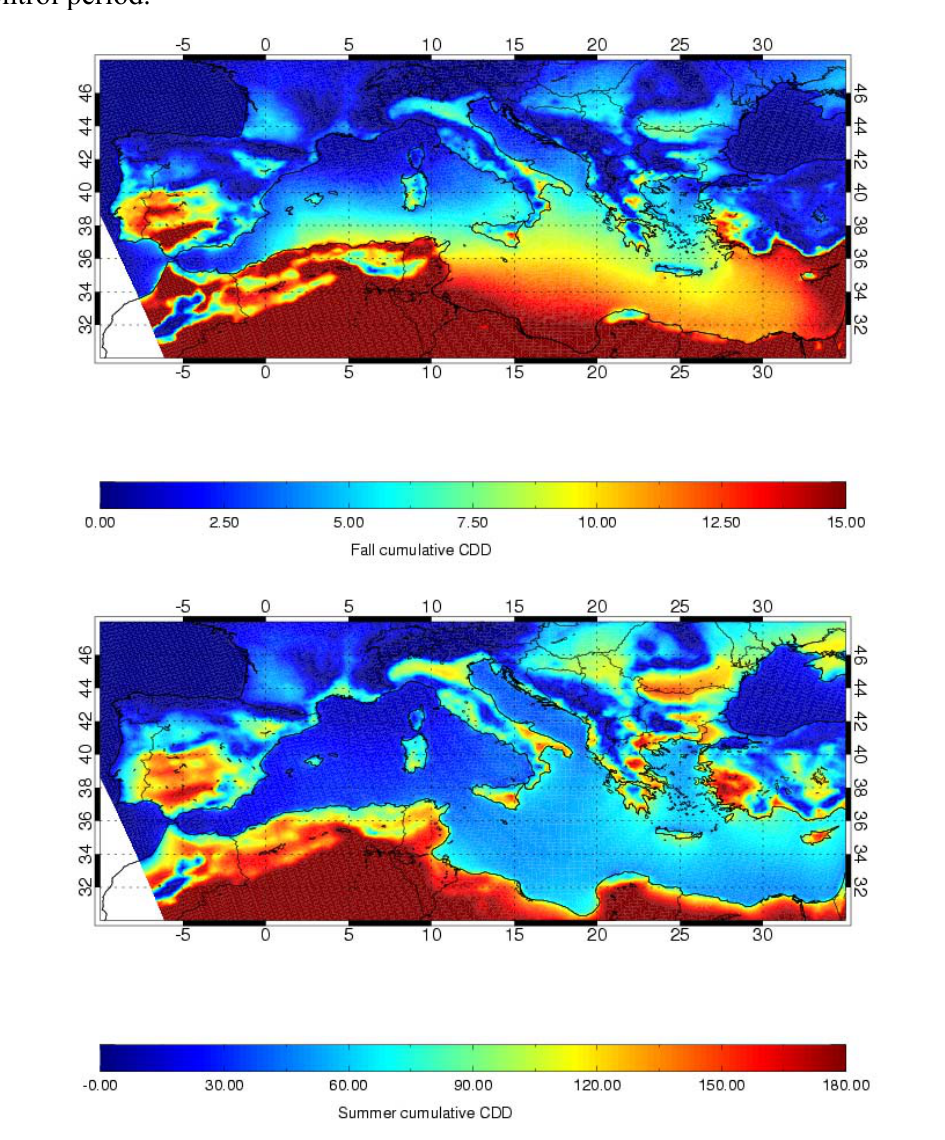
Figure 1. Changes in autumn (top) and summer (bottom) cumulative CDD between future and control